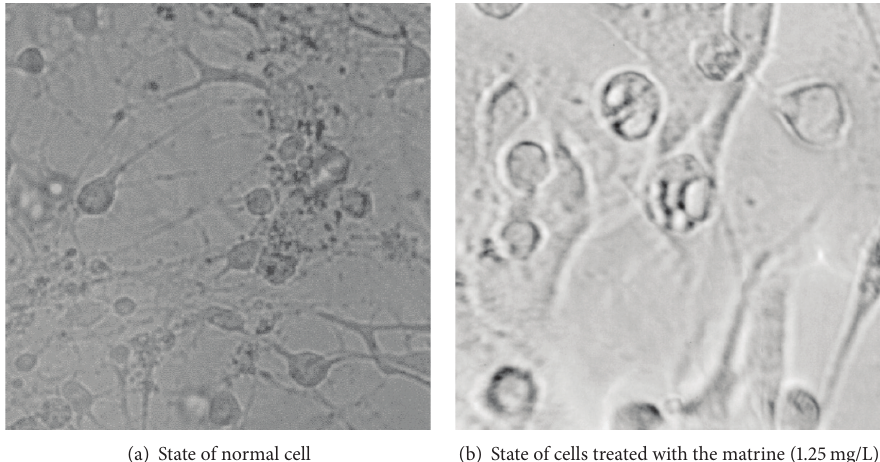
Figure 2: Cell morphology under the electron